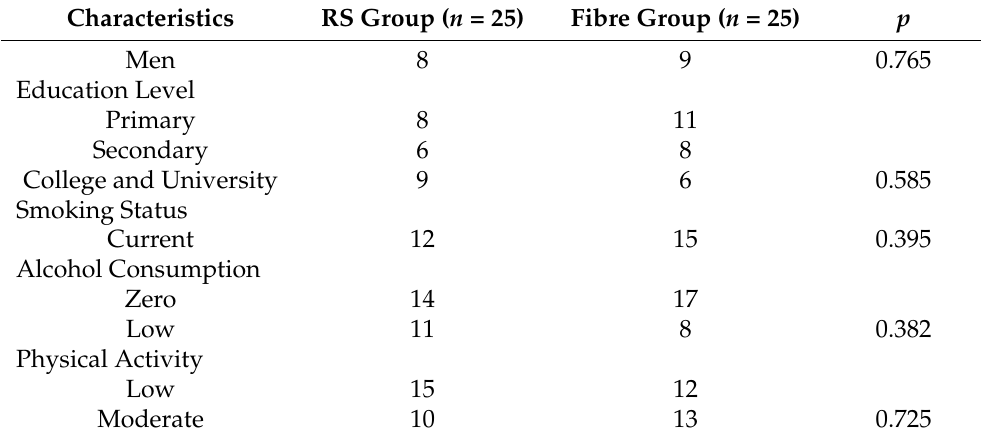
Table 1. Socio-economic and lifestyle characteristics of the sample population at the beginning of the study.